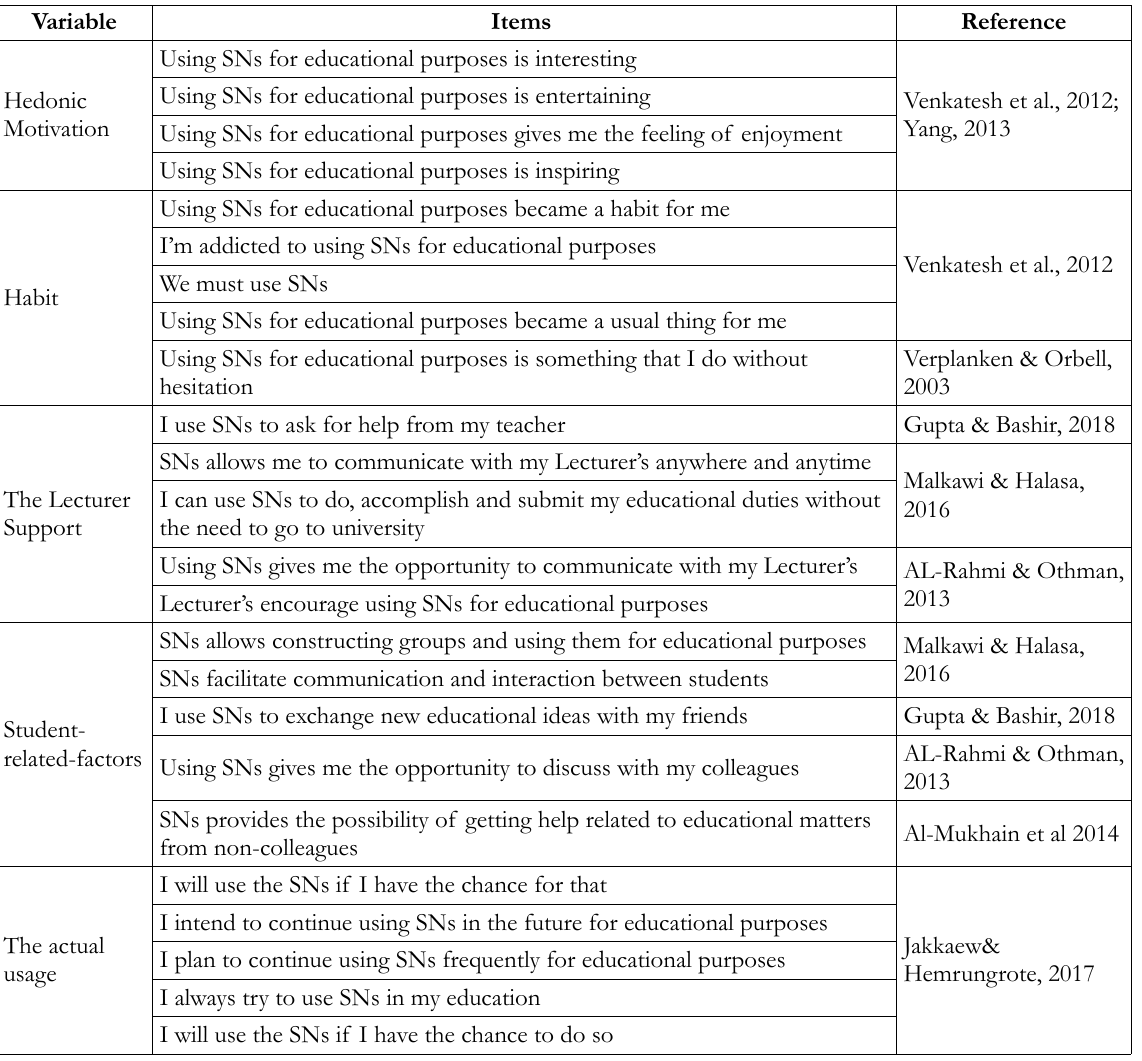
Table 1. Research Questionnaire